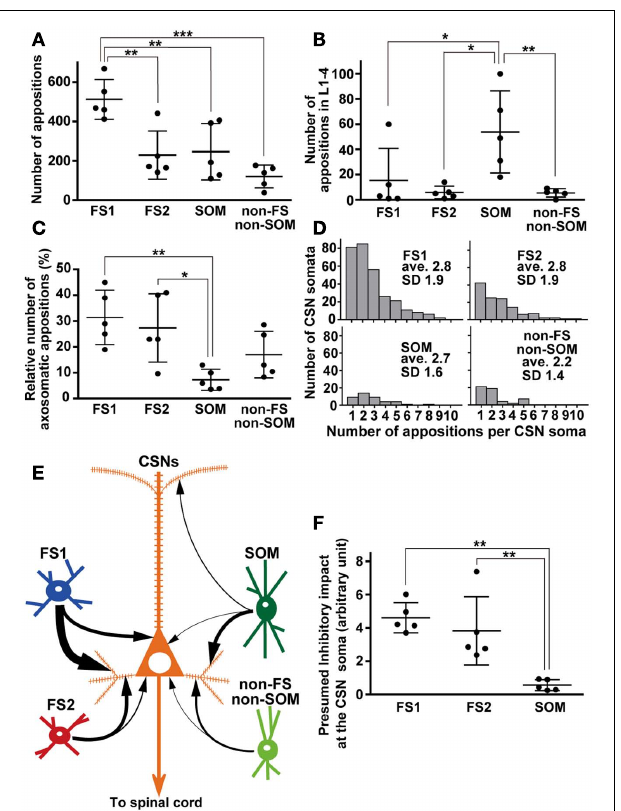
FIGURE 7 | Quantitative comparisons of appositions formed between the axon boutons of L5 interneuron subgroups and somata/dendrites of CSNs. (A) Total number of appositions.The apposition number of single FS1 neurons was at least twofold more numerous than the other interneurons. (B) The number of appositions in L1–4. Of the four groups, SOM neurons most frequently formed appositions to the apical dendrites of CSNs. (C) Relative frequency of axosomatic appositions of FS1 and FS2 neurons were in the same range, and significantly higher than that of SOM neurons. (D) The histogram of number of appositions per CSN soma. In four interneuron subgroups, average of the number of appositions per CSN soma was 2.2—2.8. (E) Summary diagram of local inhibitory connections of single FS1, FS2, SOM, and non-FS/non-SOM neurons to CSNs. Arrows indicate the relative frequency of apposed boutons per neuron (for further detail, see text). (F) Presumed inhibitory impact at the CSN soma of each L5 interneuron subgroup.The impact was calculated as [the number of appositions made by an interneuron as shown in (A)] × [the relative frequency of the interneuron subgroup in L5] × [inhibitory current amplitude per apposition (Wang et al., 2002; Xiang et al., 2002; Silberberg and Markram, 2007)].The presumed impacts of FS1 and FS2 neuron subgroups were comparable to each other, and much larger than that of SOM group. The presumed impact of non-FS/non-SOM neurons was not calculated, because no reliable data of inhibitory current amplitude is available for these neurons. All the data were shown as mean ± SD. * p < 0.05, ** p < 0.01, *** p < 0.001 byTukey’s post hoc multiple comparison test following one-way